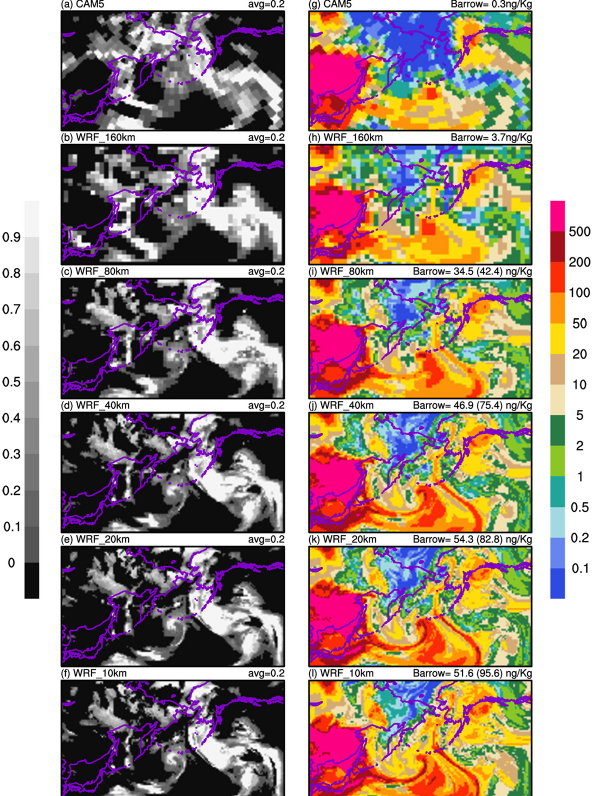
Fig. 8. The simulated (a) – (f) cloud fraction and (g) – (l) black carbon mixing ratio (ngkg − 1 ) at the second lowest model layer at 00Z of 20 April 2008. Numbers in (a) – (f) are the domain average cloud fraction. In (g) – (l) , black carbon mixing ratios at the second lowest model over Barrow are given, and numbers in parentheses are the maximum black carbon concentration within the 160km cell over